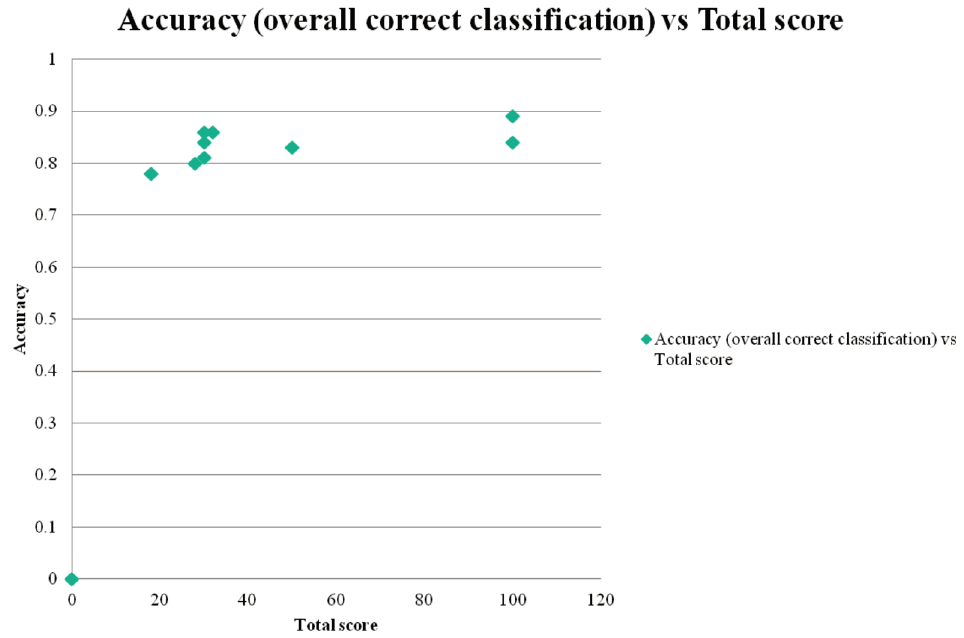
Figure 1. Scatter plot of test correct classification accuracy versus total test score (= surrogate measure of test administration time).